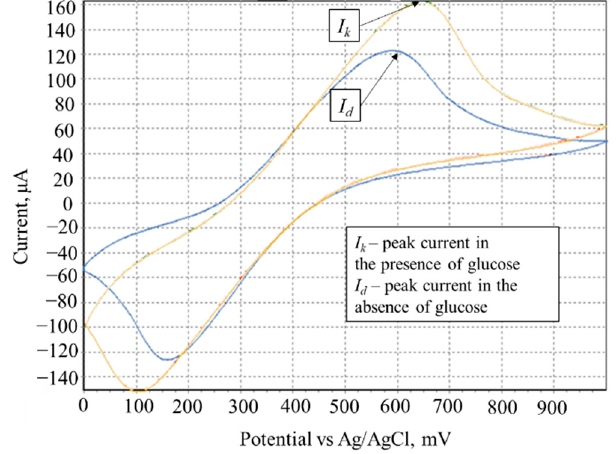
Figure 3. Determination of the constant of interaction of the mediator with S. cerevisiae yeast cells by cyclic voltammetry. The voltammograms based on ferrocene mediator (scan rate, 20 mV/s) in the presence of glucose (brown line) and in the absence of glucose (blue line) are presented.